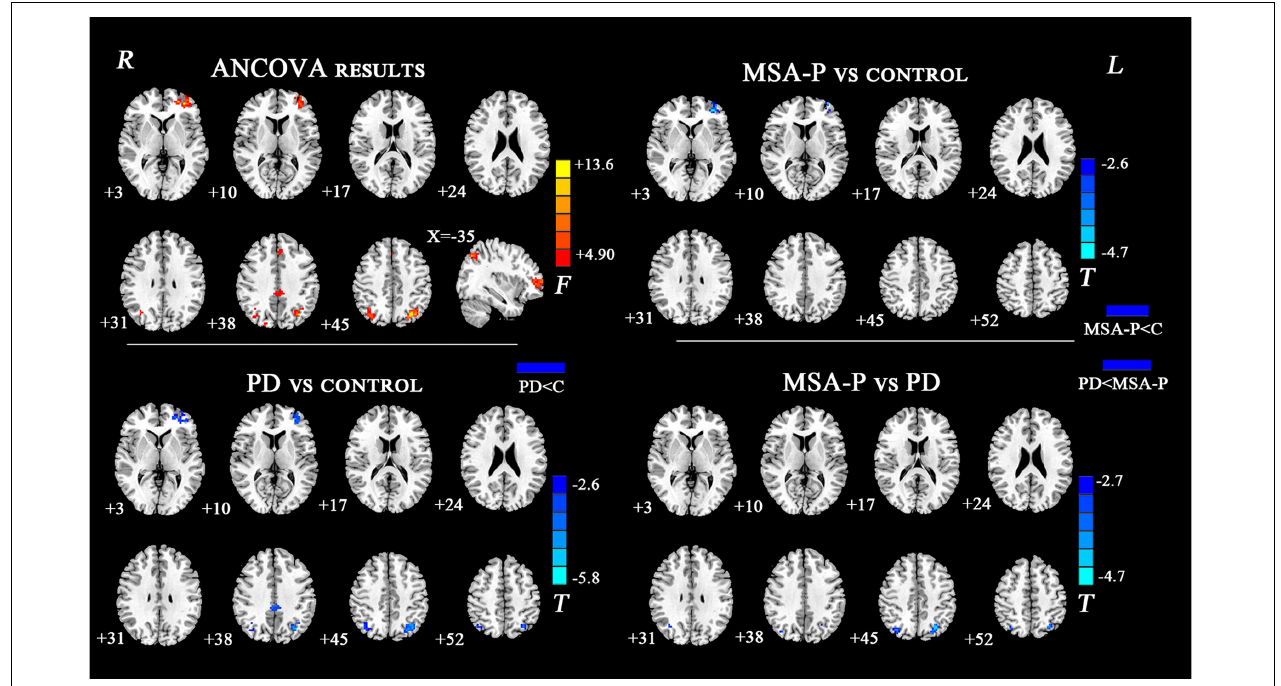
FIGURE 1 | Statistical maps showing FC differences of left DN in different brain regions among the MSA-P, PD, and control groups. The threshold for display was set to p < 0.01 corrected by AlphaSim; Results are in MNI space; Red color represents the increased correlation while the blue color represents the decreased correlation; R, right; L, left; C,